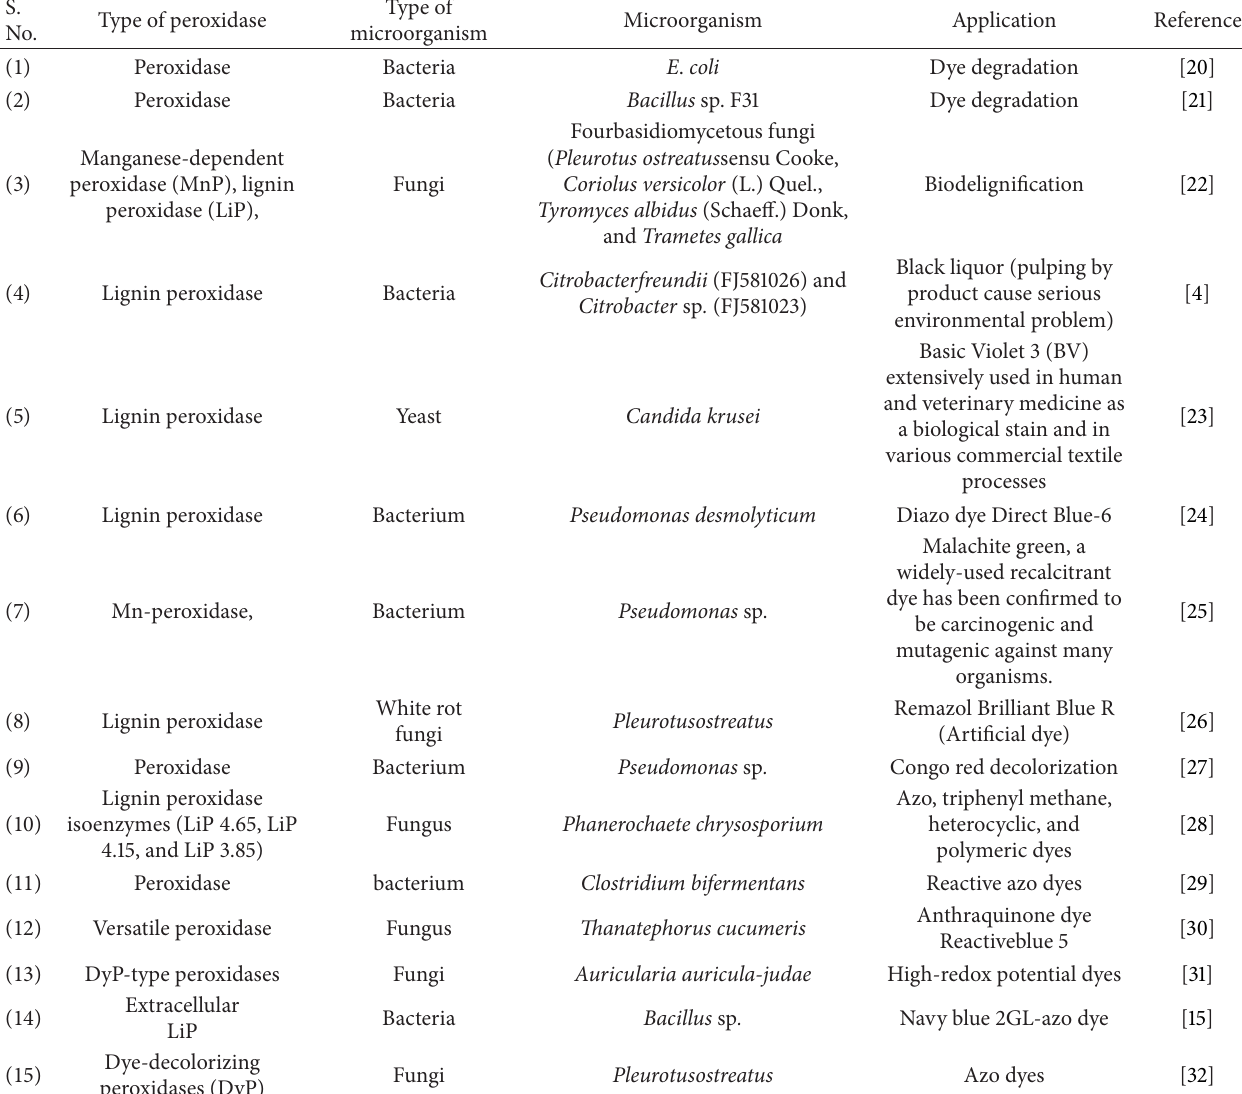
Table 1: Decolorization and detoxification of synthetic, textile dyes, and other industry effluent by microbial peroxidase(s).